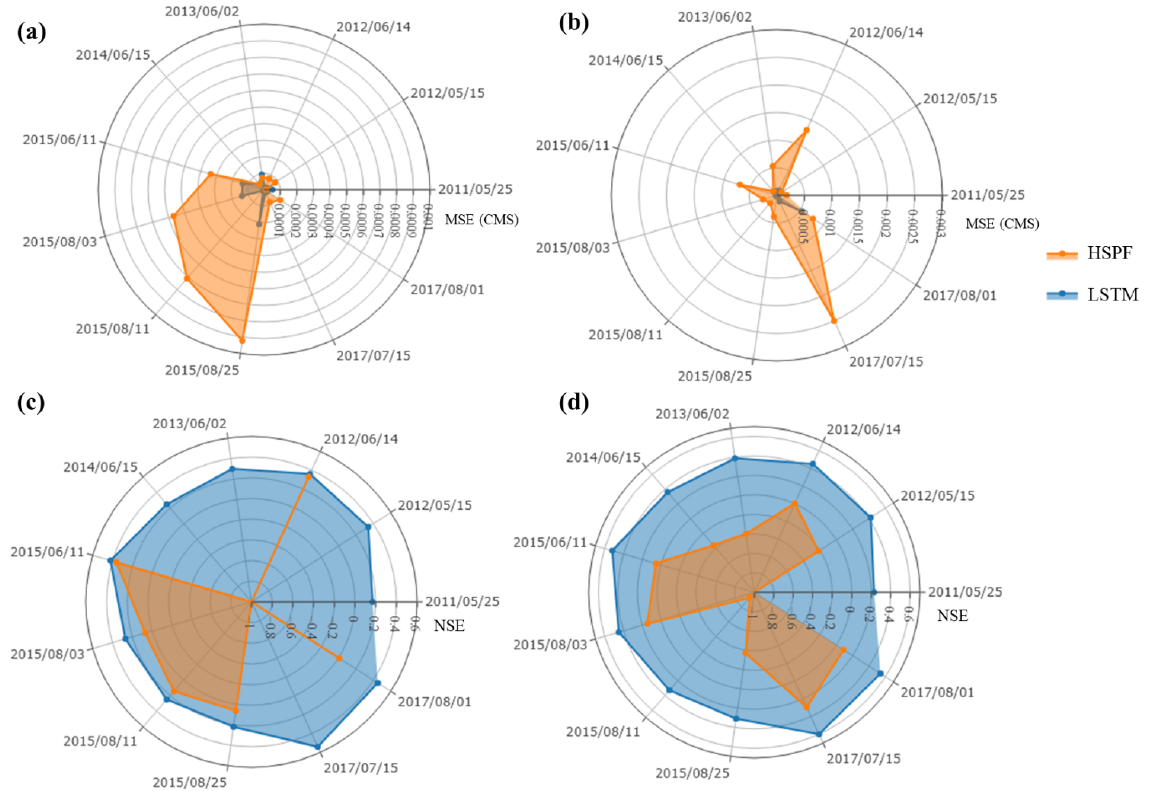
Figure 5. Comparison of the hydrological simulation during storm events: (a) MSE value of the surface flow, (b) MSE value of the subsurface flow, (c) NSE value of the surface flow, and (d) NSE value of the subsurface